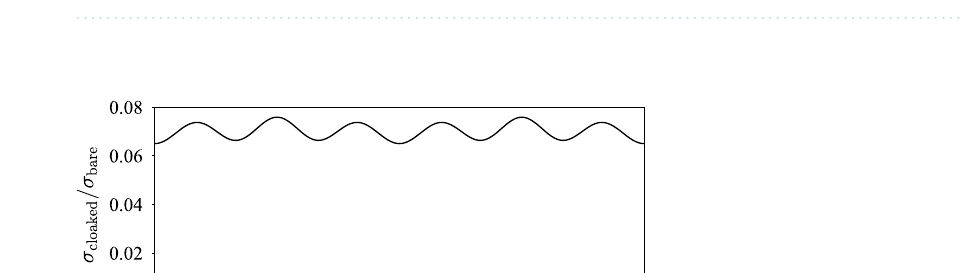
p in when a monopole source p in − 5 R , 5 R ) . The dots in (b) represent the positions of the rubber-lead ( = − −